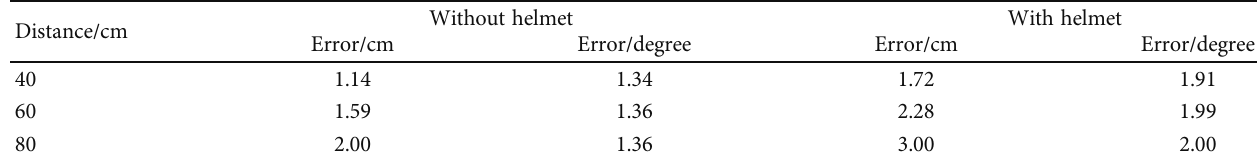
Figure 12: Visualized results of gaze marker landing estimation with subjects at 80cm away from the screen. Table 1: Mean error for the gaze marker landing estimation at di ff erent